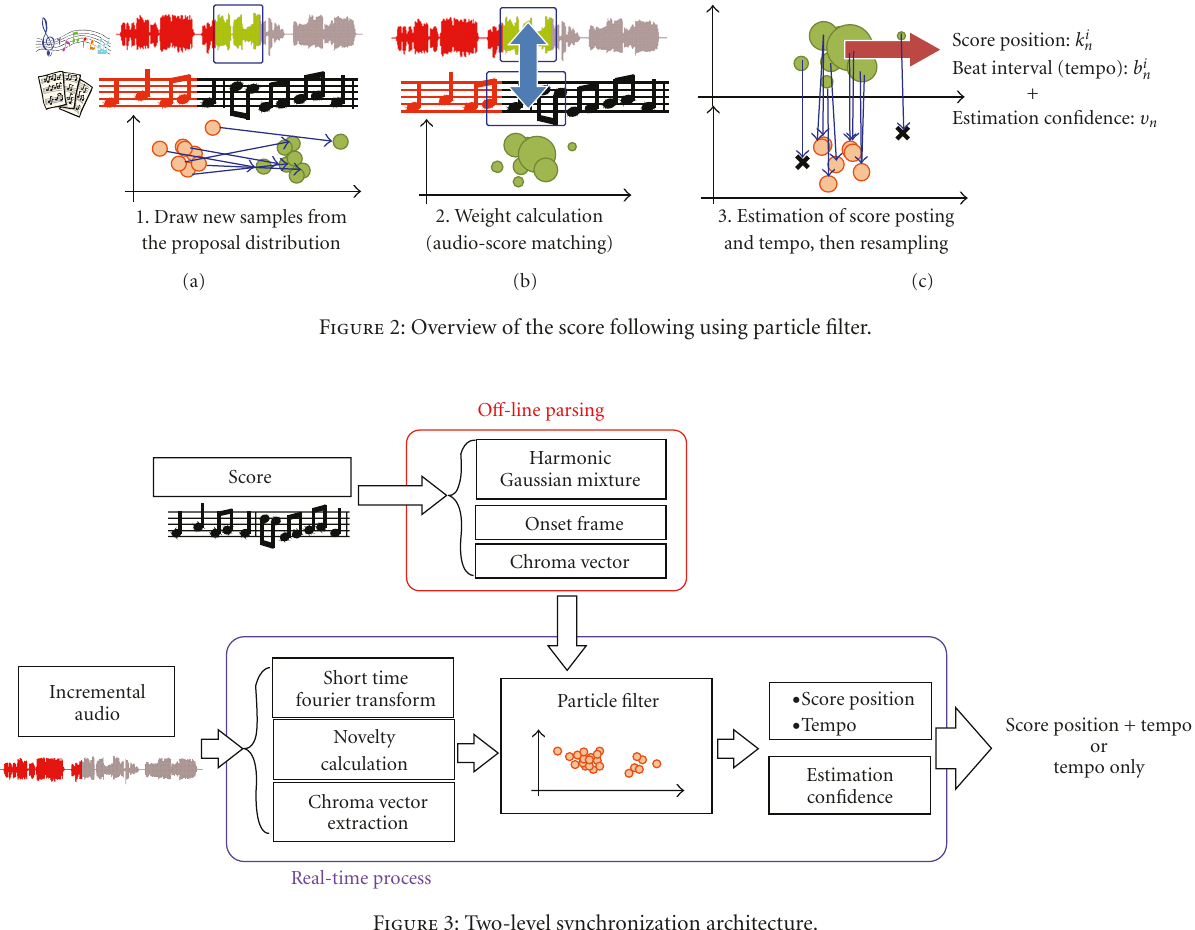
Figure 3: Two-level synchronization